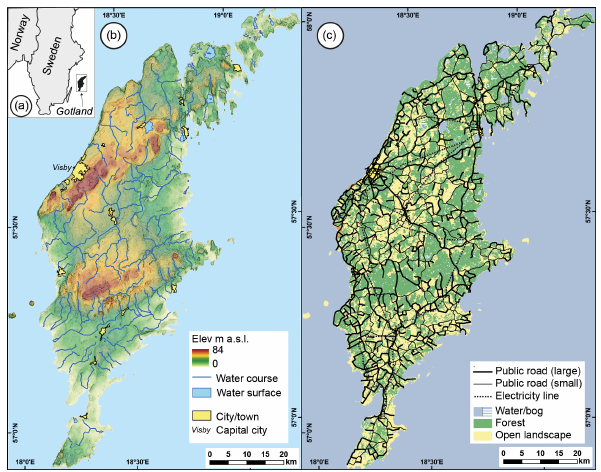
Figure 1. Study area: (a) location in Scandinavia; (b) topography, hydrology, and major settlements; (c) road network and land